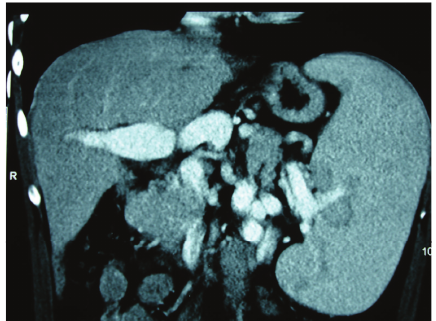
Figure 3: Postoperative angiotomography showing patent gastro- portal anastomosis.